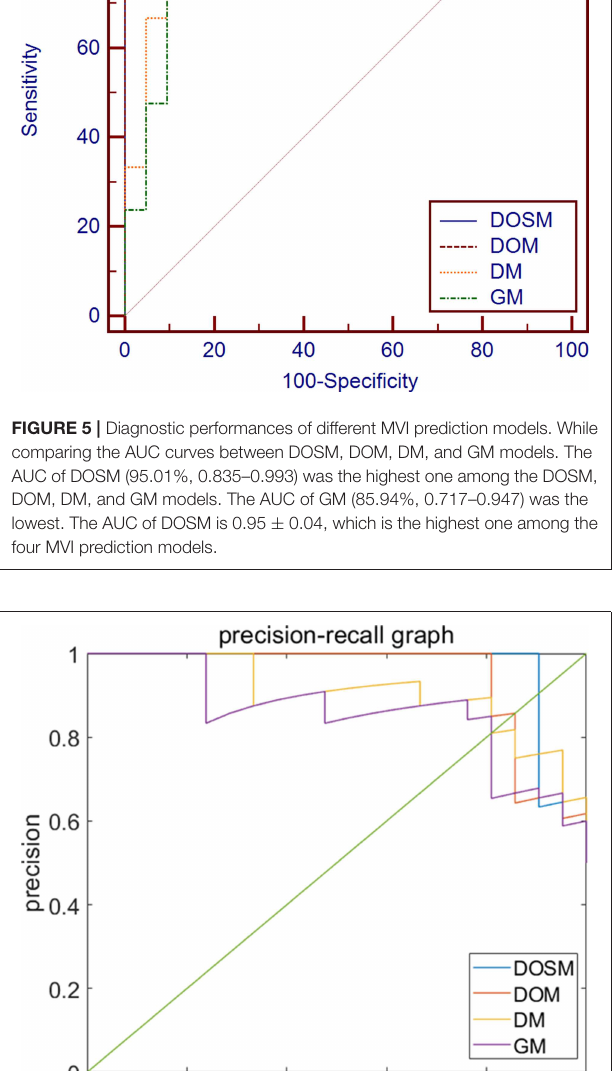
based on grayscale ultrasound images, ultrasound elastography images, and contrast enhanced ultrasound images (19,